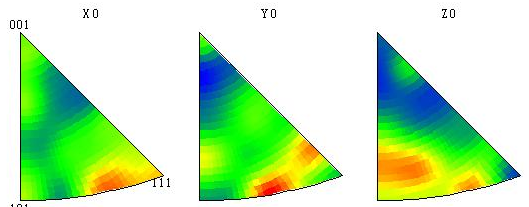
Figure 9. Inverse pole diagrams of Al-Mg alloyed additive on different planes.